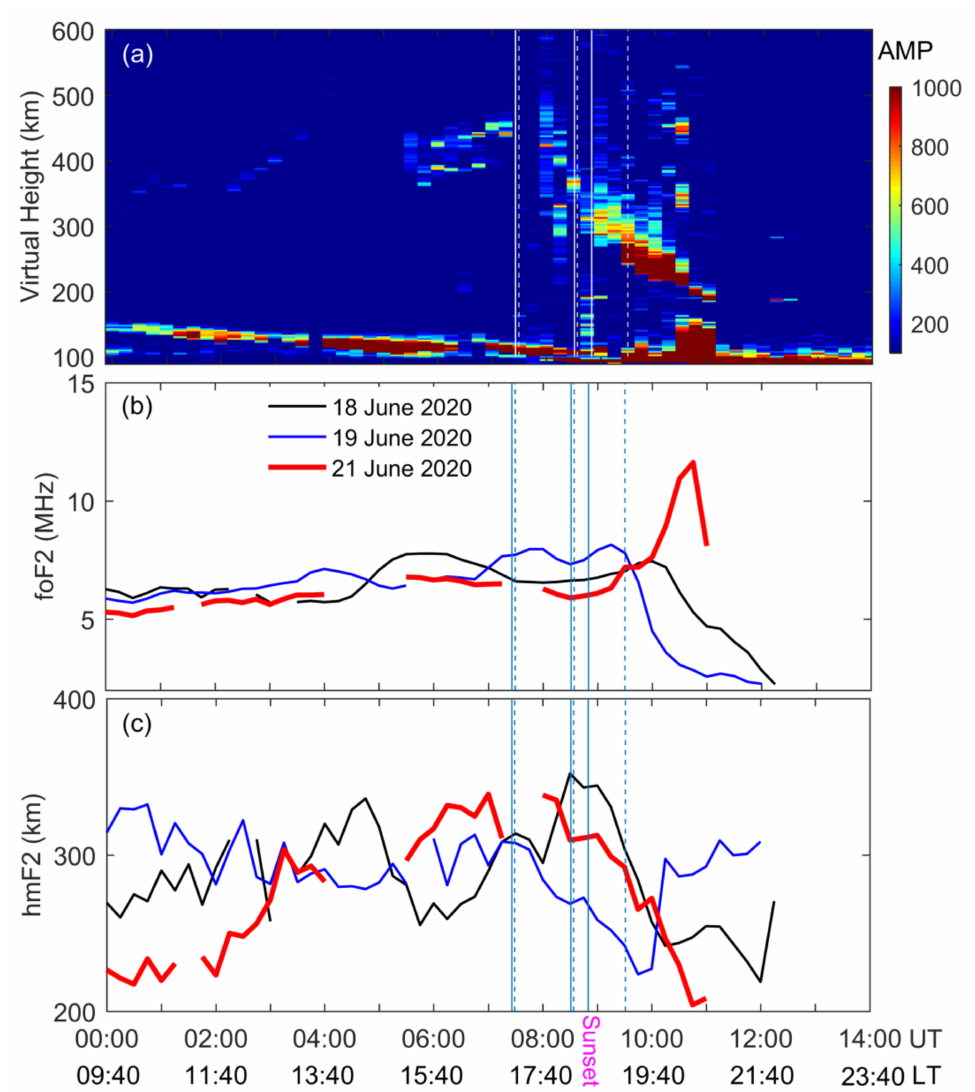
Figure 3. Evolution of the height-time-amplitude (HTA) and the critical frequency ( f o F 2 ) and peak height ( h m F 2 ) of the F 2 layer on the solar eclipse day (red line) and the reference days (18–19 June). ( a ) The HTA plot on the solar eclipse day. ( b ) The f o F 2 and ( c ) h m F 2 plot on the solar eclipse day (red) and reference days. The solid vertical lines represent the beginning, maximum obscuration of the solar eclipse, and the sunset time at sea level (~0 km). The dotted vertical lines represent the beginning, maximum, and end of the obscuration at ionospheric height (~200